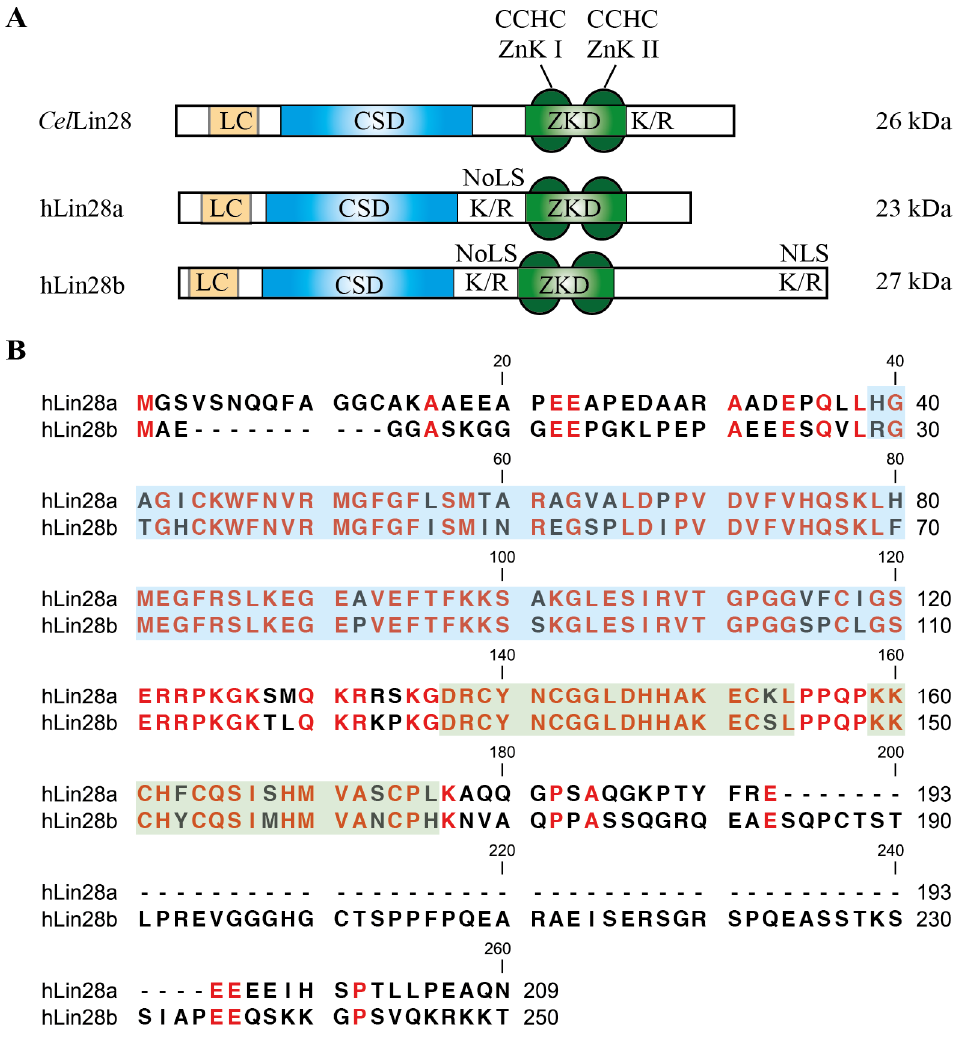
Figure 1. Domain organization of Lin28. ( A ) Caenorhabditis elegans ( Cel ) and human (h) Lin28a/Lin28b contain two RNA-binding domains (RBDs): an N-terminal cold-shock domain (CSD) and a C-terminal Zn-knuckle domain (ZKD) comprised of two retroviral type CCHC Zn knuckles (ZnK). Additionally, Lin28 harbors low-complexity sequences, Lys/Arg (K/R)-rich stretches, bipartite nuclear localization signals (NLS) or putative nucleolar localization sequences (NoLS); ( B ) Sequence alignment of hLin28a and hLin28B. Amino acids belonging to CSD or ZKD are shaded in blue or green,